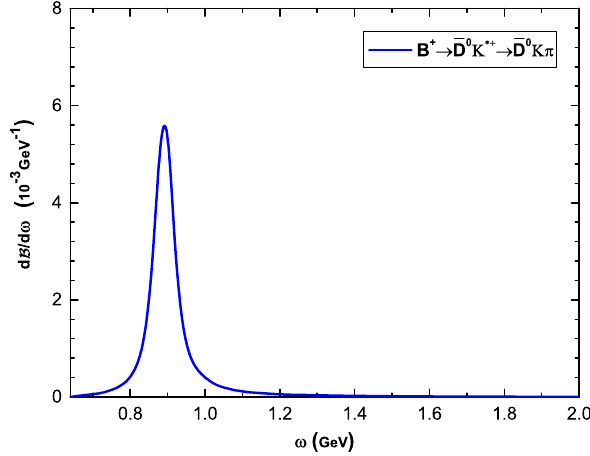
Fig. 3 The PQCD prediction for the ω -dependence of the differential branching ratio for the decay mode B + → ¯ D 0 K ∗+ → ¯ D 0 K